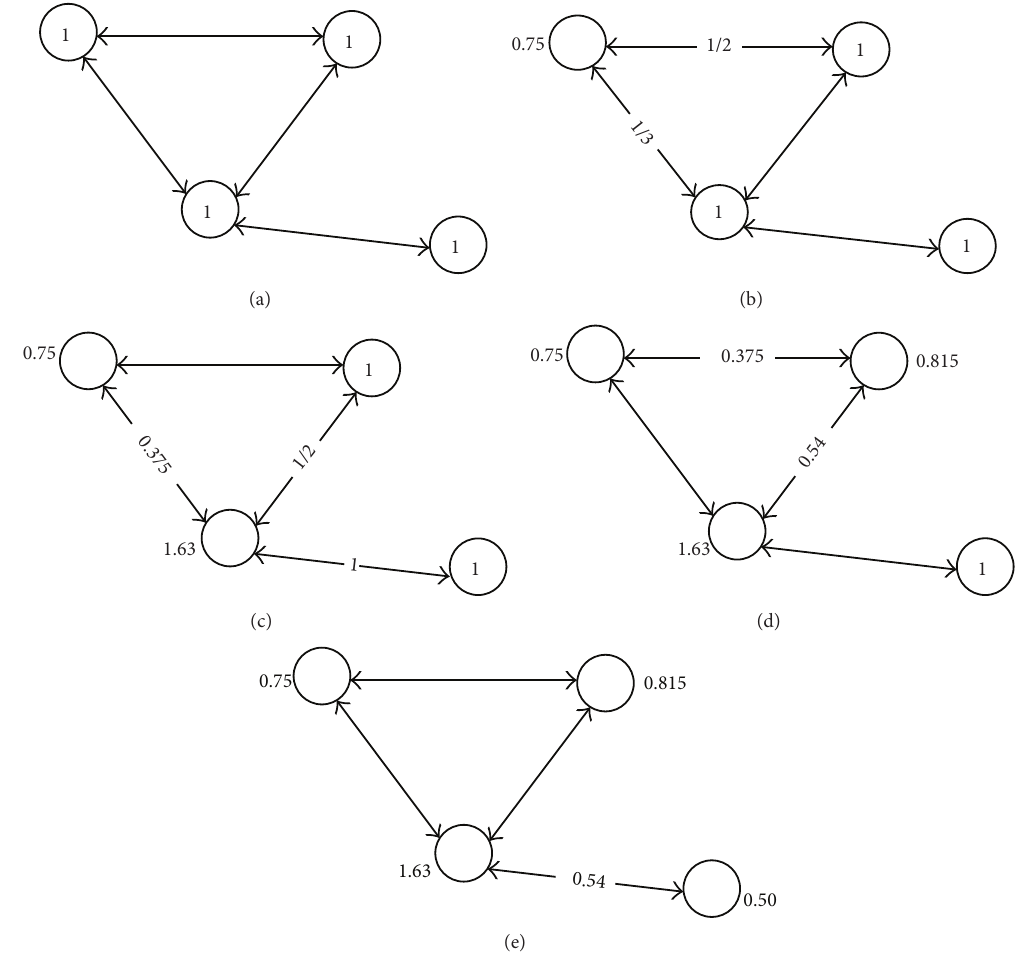
Figure 10: Visualization of the steps of PageRank